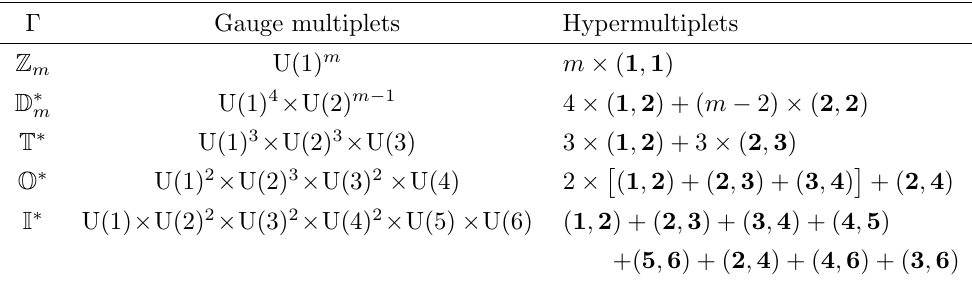
Table 3 . N = 2 multiplets for the di(cid:11)erent quivers associated to the groups